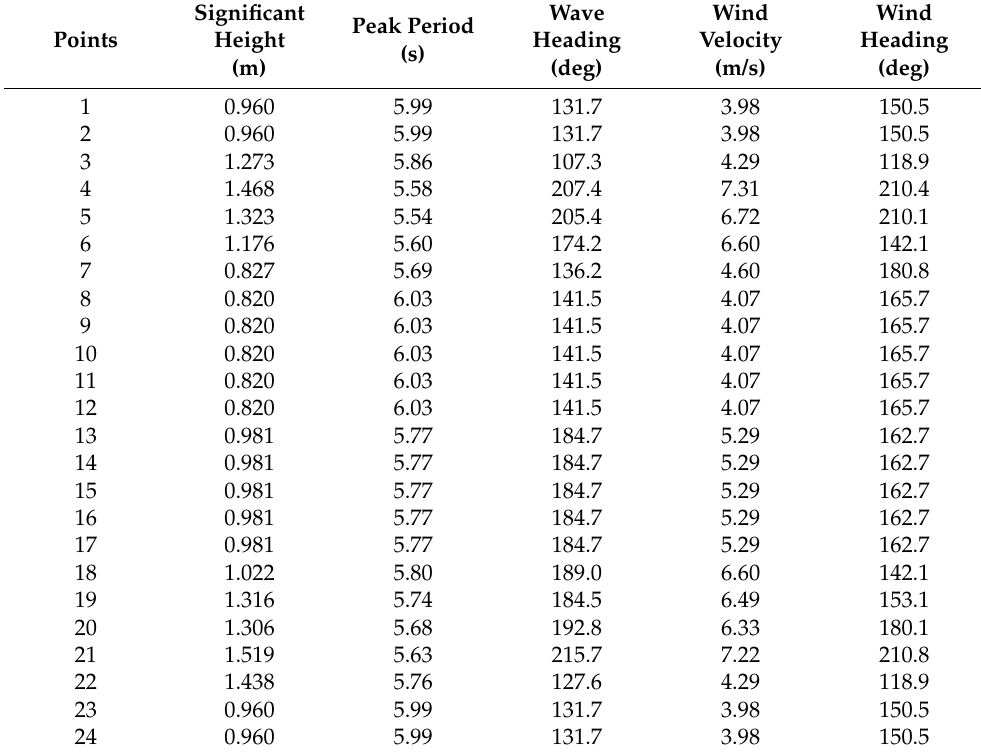
Table A3. Sea state per route point in March to May season.